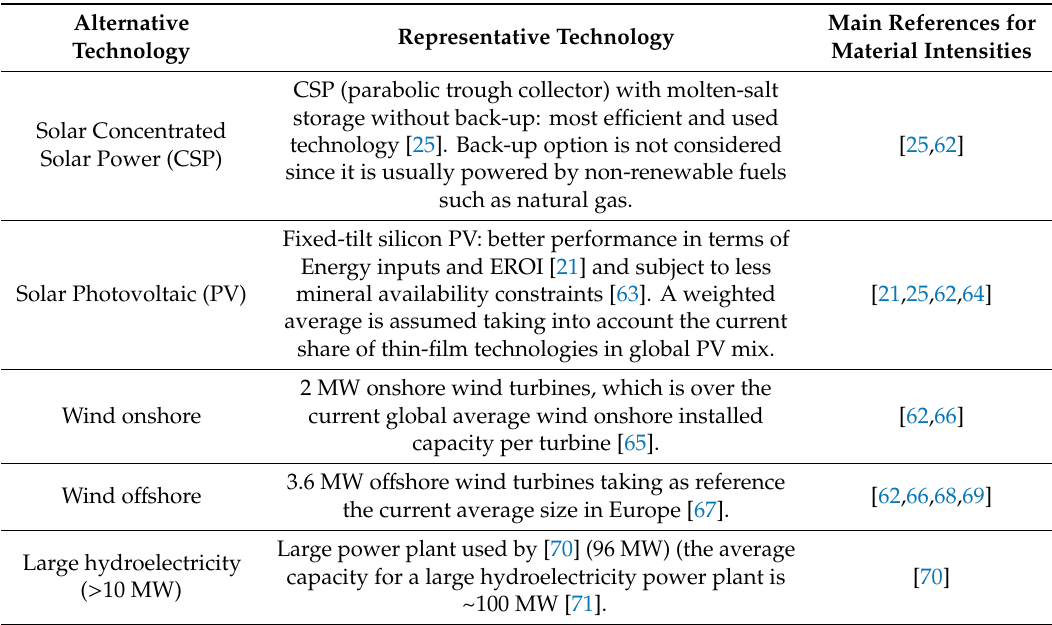
Table 1. Representative alternative technologies and main references considered for their material intensities. See Supplementary Material for